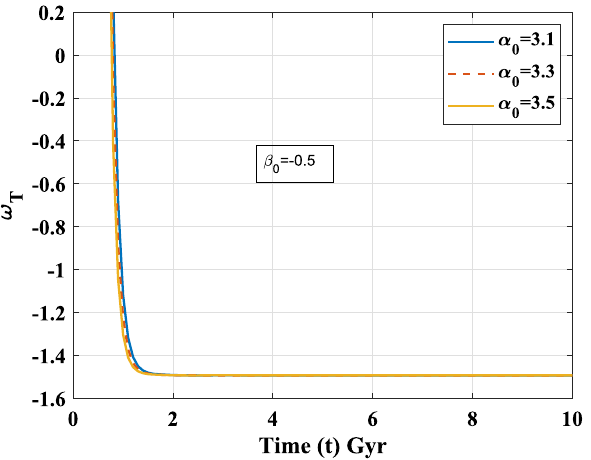
for k = 1 . 9, α 1 = 1 . 2, α 2 = 0 . 52, T